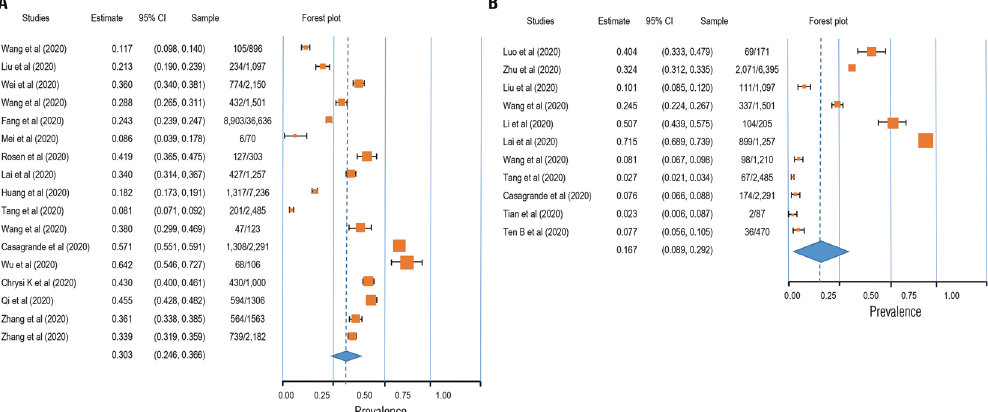
Fig. 4 Forest plot for meta-analytic results of the prevalence of insomnia and PTSD symptoms. The squares colored by orange represent the point estimation for effect towards corresponding study, with the large square size for high effect size. The orange diamond represent meta-analytic effect size.